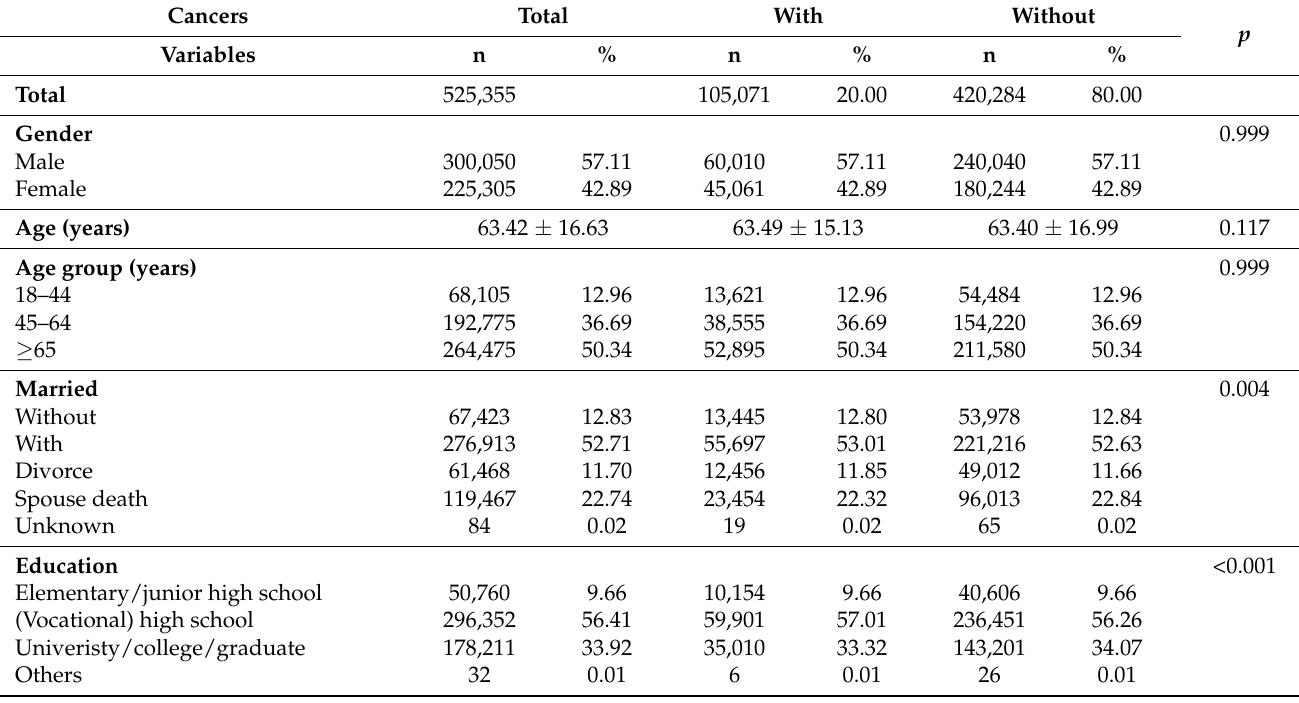
Table 1. Characteristics of the study